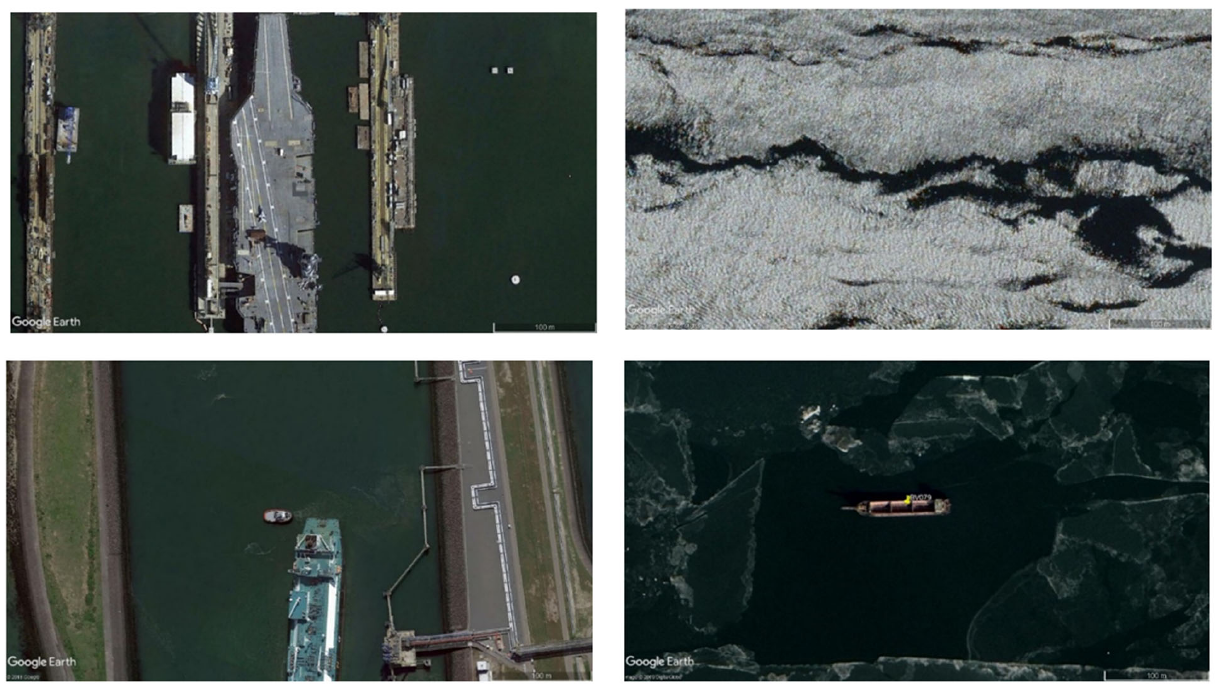
Figure A5. The example images from VHRShips with calm (left column) and rough (right column) sea conditions.